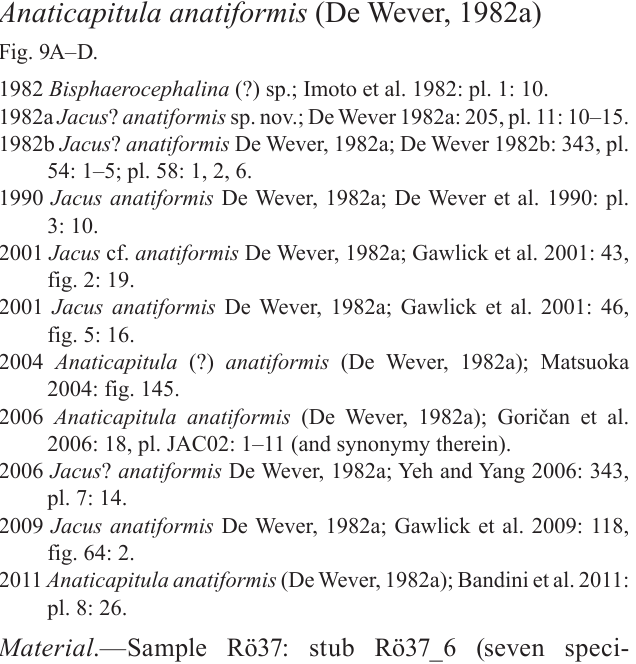
Fig. 8. Radiolarians from Mount Rettenstein, Austria, Pliensbachian, Early Jurassic. A – G . Pantanellium browni Pessagno and Blome, 1980. A – F .